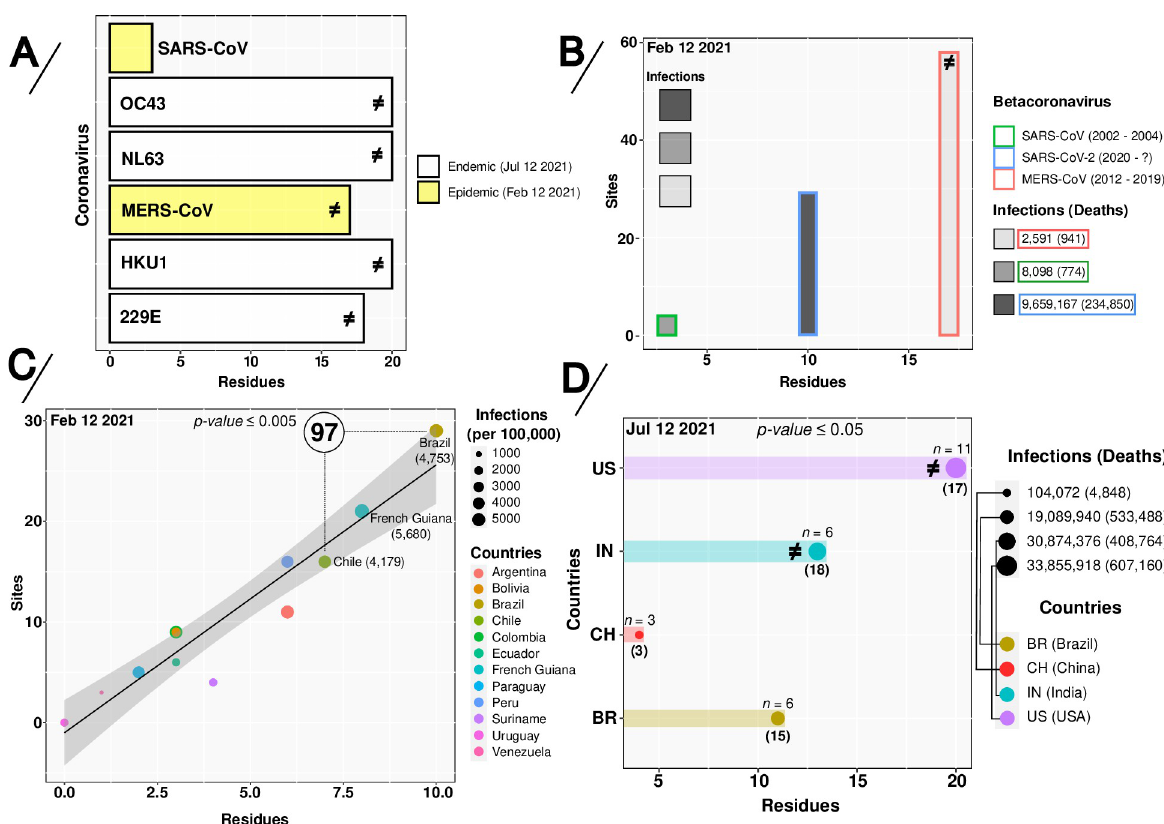
Fig 1. Directionally-evolving sites and residues in alpha- (229E and NL63) and beta- (OC43, HKU1, SARS-CoV, MERS-CoV and SARS-CoV-2) coronavirus sequences. ( A ) Directed-evolving residues in six different endemic and epidemic human coronaviruses (HCoVs), ( B ) Sites and residues vs infections in epidemic and pandemic coronaviruses (CoVs). ( C ) Linear-regression curve and co-relationship on the absolute amount of sites and/or residues under directional-positive selection given SARS-CoV-2 infections per 100,000 people from South America countries and ( D ) the total number of SARS-CoV-2 infections in Brazil, China, India and the USA. In panels A, B and D, the symbol 6¼ represents the presence of recombination breakpoints signals. In panel B, on the upper left, different intensities in grayscale are directly related to the number of infections. In panel C, the number inside the circle represents the amount of clusters found in Brazil and Chile. In panel D, n represents the amount of SARS-CoV-2 variants and the numbers in parentheses indicate sites under directional and convergent evolution in the Spike-encoding protein. P-values were obtained by considering the DEPS [sites and/or residues] vs infections per 100.000 inhabitants from one-way analysis of variance (ANOVA) and nonparametric methods, as described in the Statistical analysis section. Colors and symbols used in the panels are defined in the legend to the right of the